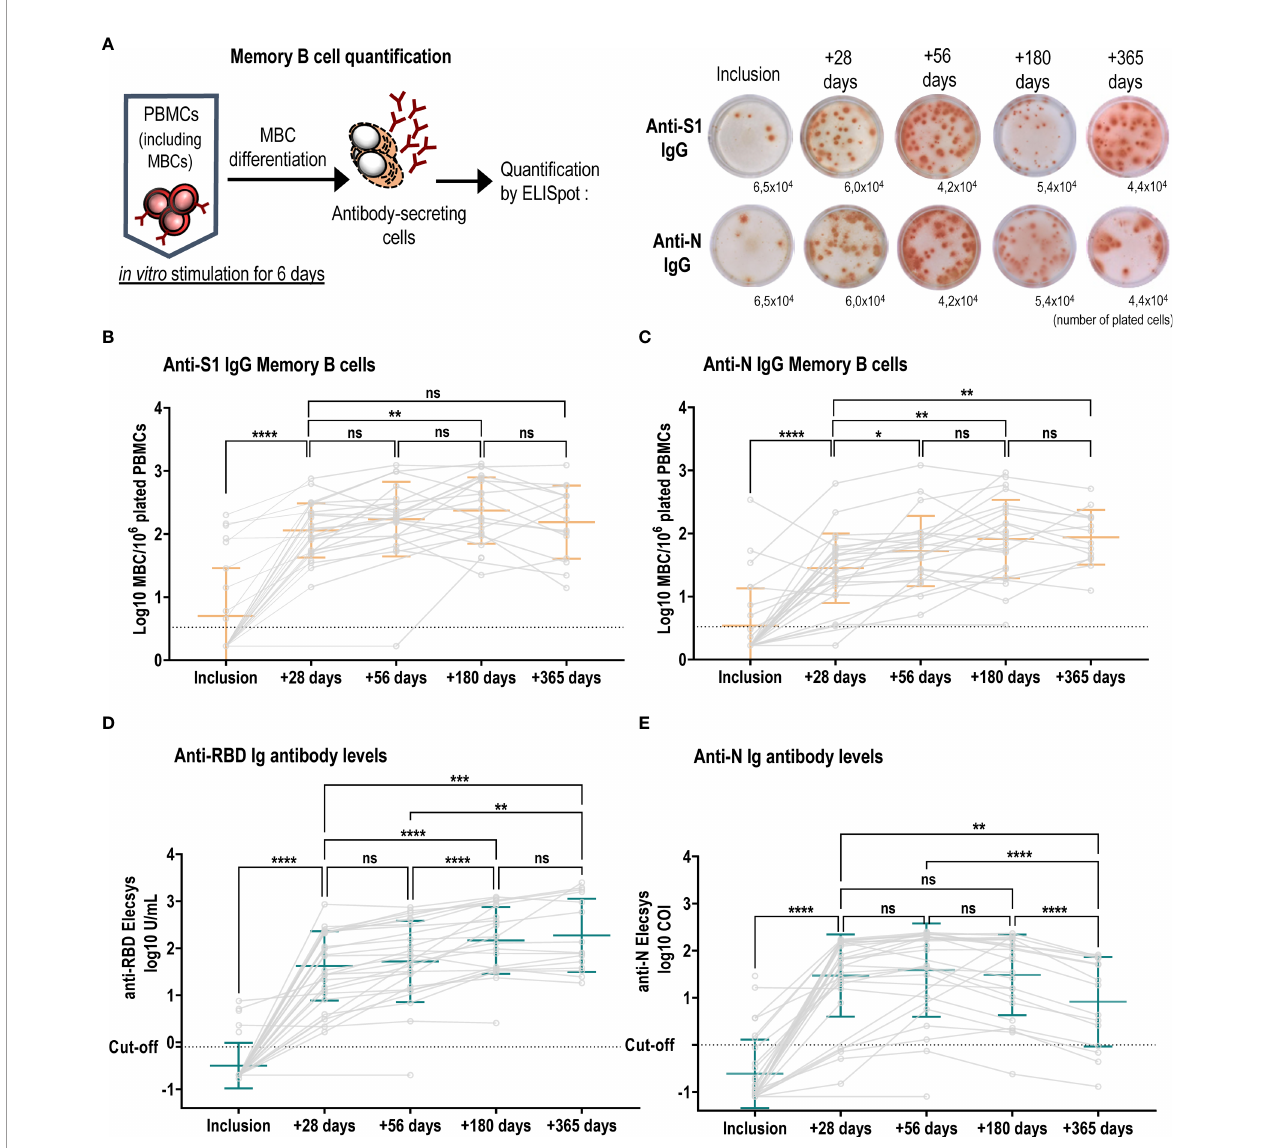
FIGURE 2 | Long-term persistence of SARS-CoV-2-speci fi c memory B cells and antibody responses. (A) Left schematic illustrates MBC in vitro mitogenic stimulation and differentiation required to become antibody secreting cells. Right, representative wells of anti-S1 IgG and anti-N IgG MBC ELISpot in patient number 9, one spot corresponds to one MBC, and the indicated numbers are stimulated plated cells per well. Numbers of anti-S1-speci fi c (B) and anti-N- speci fi c (C) IgG MBCs were plotted at each visit and individual patient values are shown in grey circles and connected by grey lines. Anti-S1-speci fi c MBCs increased over time (median ratio at +56 days/inclusion: 52, at +180 days/inclusion: 62.6 and at median ratio +365 days/inclusion: 85.1) and were higher as compared to anti-N speci fi c IgG MBCs (median ratio at +28 days/inclusion: 15; at +56 days/inclusion: 19, at +180 days/inclusion: 29, + 365 days/inclusion: 34). Mean +/- SD is shown in orange. Kinetics of anti-RBD (D) and anti-N (E) antibody titres over the course of one-year post infection. Individual values are shown in grey circles and patients are connected by grey lines. Mean +/- SD is shown in green. (D) anti-RBD Ig antibodies increased over the fi rst 6 months [inclusion vs +28 days mean log10 U/mL: -0.50 ± 0.48 vs 1.62 ± 0.74, p<0.0001, (+28 days vs +180 days mean log10 U/mL: 1.62 ± 0.74 vs 2.16 ± 0.72, p<0.0001)], and were stabilized between 6 months and a year (+180 days vs +365 days mean log10 U/mL: 2.16 ± 0.72 vs 2.27 ± 0.78, p=0.6361), whereas (E) anti-N antibodies increased signi fi cantly between inclusion and +56 days: mean log10 COI: -0.61 ± 0.73 vs 1.58 ± 0.99, p<0.0001) followed by a signi fi cant decline up to one year (+56 days vs +360 days mean log10 COI: 1.58 vs 0.91, p<0.0001). ns, not signi fi cant; ****p ≤ 0.0001; ***p ≤ 0.001; **p ≤ 0.01; *p ≤